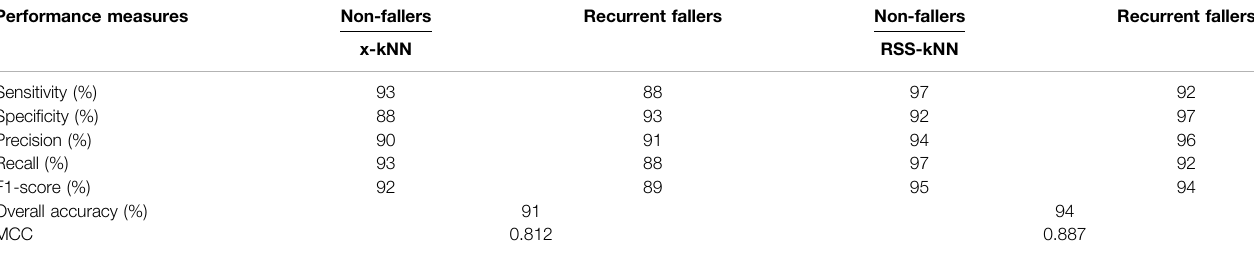
TABLE 2 | Comparison of the kNN classi fi cation using normalized cross-correlation of the x -axis component and root-sum-of-square of the 3D acceleration signals. Performance measures